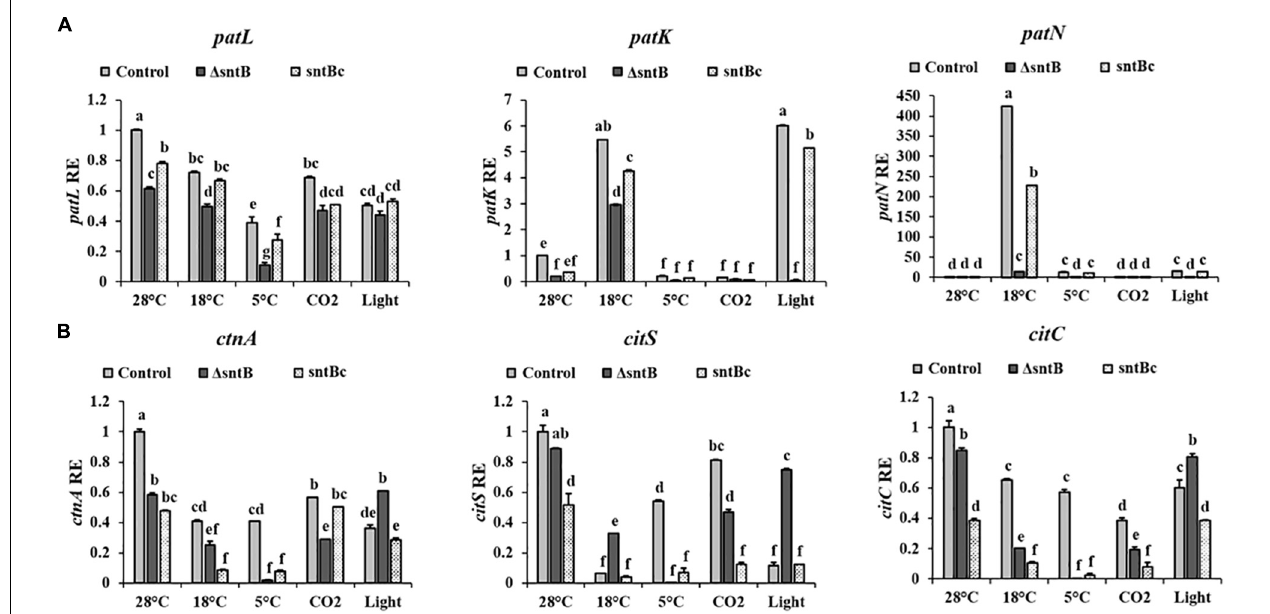
FIGURE 5 | Effect of abiotic factors on relative expression of mycotoxin cluster genes. The three Penicillium strains (control, (cid:49) sntB , and sntB c) were grown on YES agar media at 28 ◦ C for 48 h in the dark and then subjected to different treatment conditions as mentioned in Figure 4 . RNA was extracted and the relative expression of patulin cluster genes (A) , and citrinin cluster genes (B) was evaluated. Error bars represent the standard error of the mean (SEM) across three technical replicates. One-way ANOVA differences were considered significant when p < 0.05. Different letters above the columns indicate statistically significant differences between the strains as determined using Tukey’s single-step multiple comparison